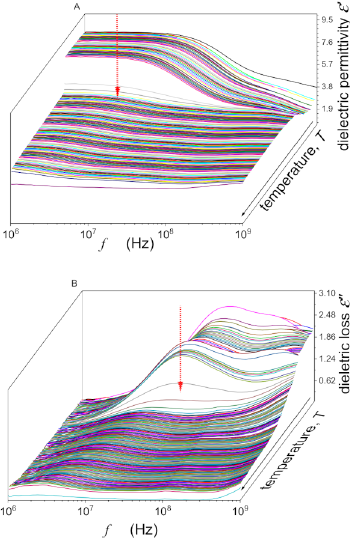
Figure 1. The general view of temperature and frequency evolutions of dielectric spectra for the real ( ε (cid:48) ) and imaginary ( ε (cid:48)(cid:48) ) components of dielectric permittivity in pure 12CB. Curves are related to frequency scans for subsequent temperatures. Note the appearance of loss curves for ε (cid:48)(cid:48) ( f ) and the static (horizontal) domain for ε (cid:48) ( f ) . The latter is related to the dielectric constant. Red arrows indicate Isotropic–Smectic A “clearing”